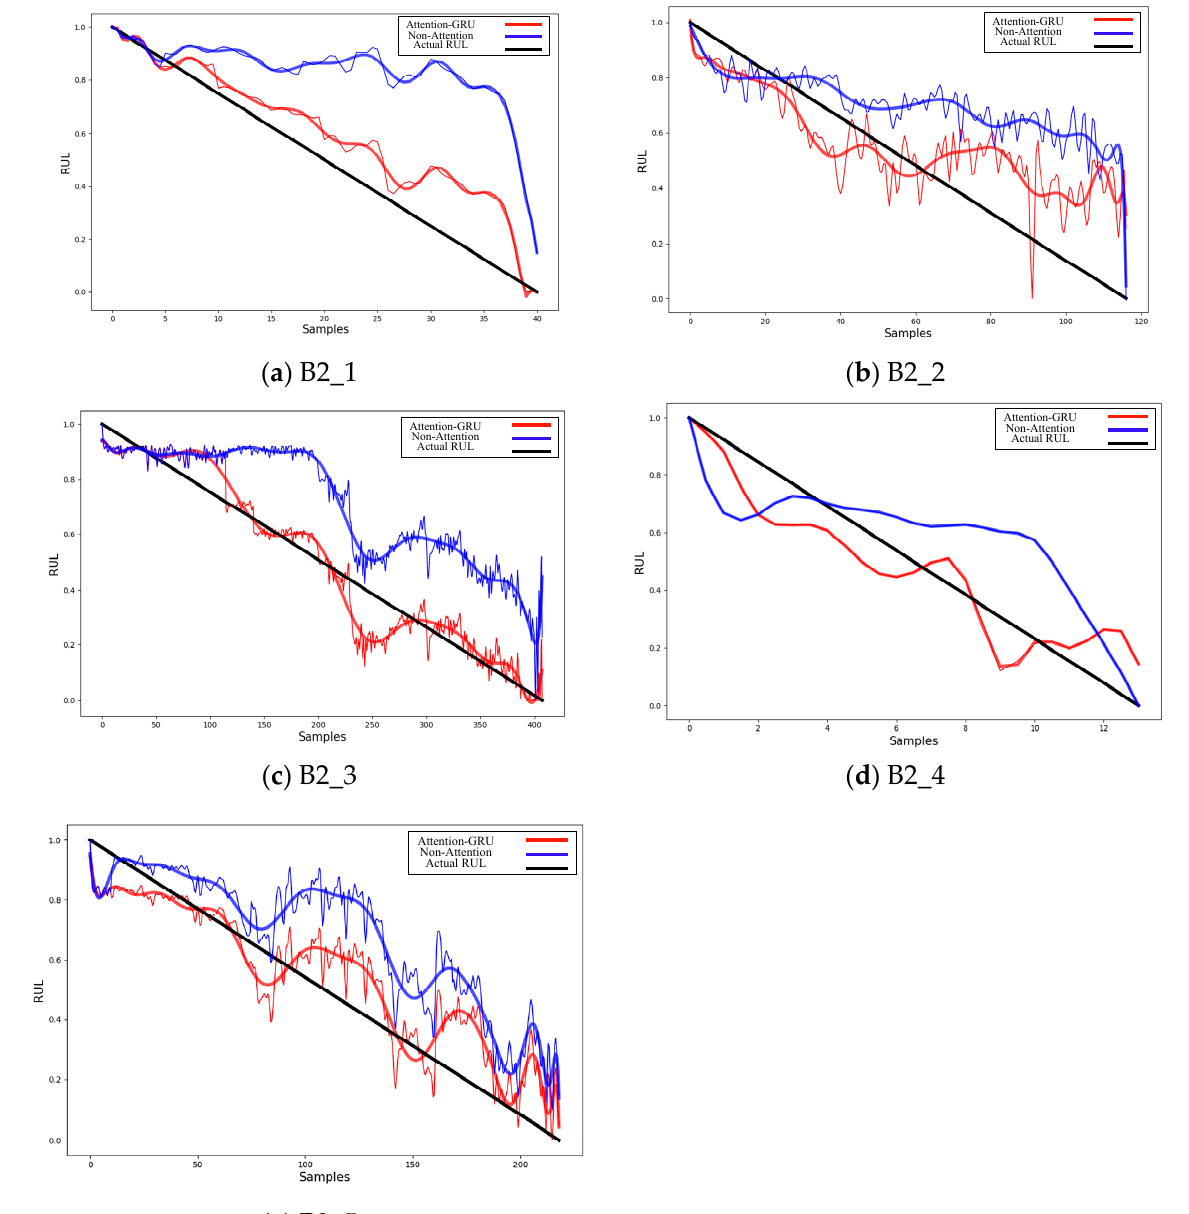
Figure 10. Comparison of RUL prediction results of bearings under working condition 2. Comparative experiments are also performed between the LSTM model proposed